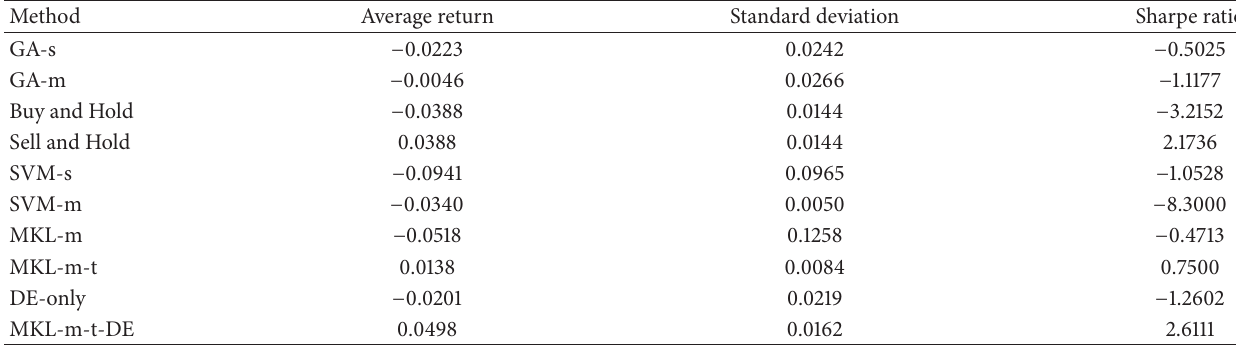
Table 11: Sharpe ratios for the baseline, benchmark, and proposed